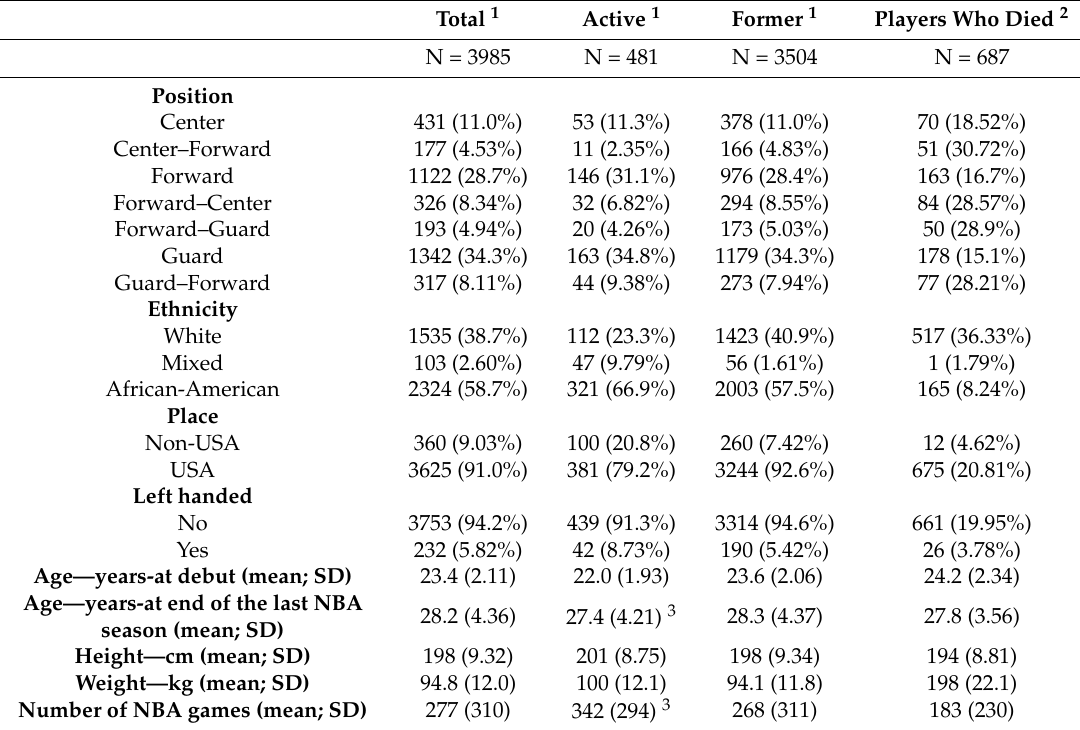
1 Percentages represent proportions of all, active, and former players, respectively; 2 Percentages represent the number of players who died, as a proportion of all former players; 3 These measures are not comparable because the active players are still